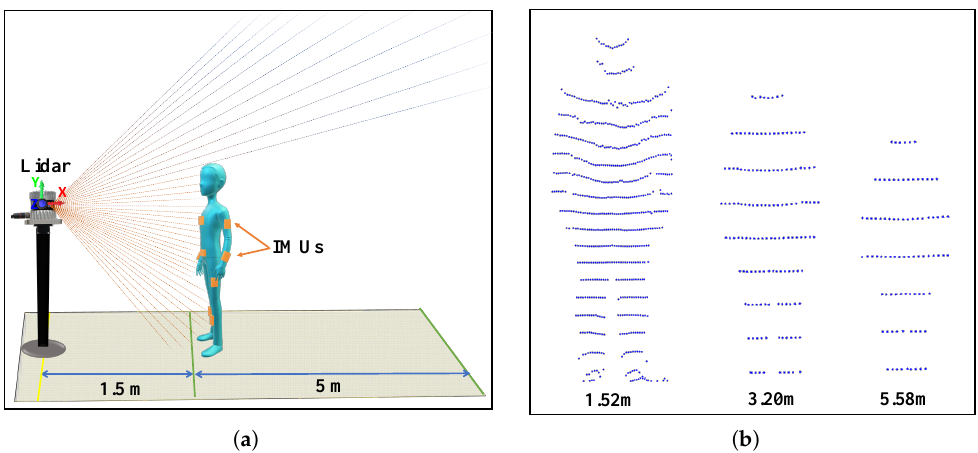
Figure 3. ( a ) Proposed multi-sensor system setup, ( b ) Human body tracking at different distance in indoor environment by 3D